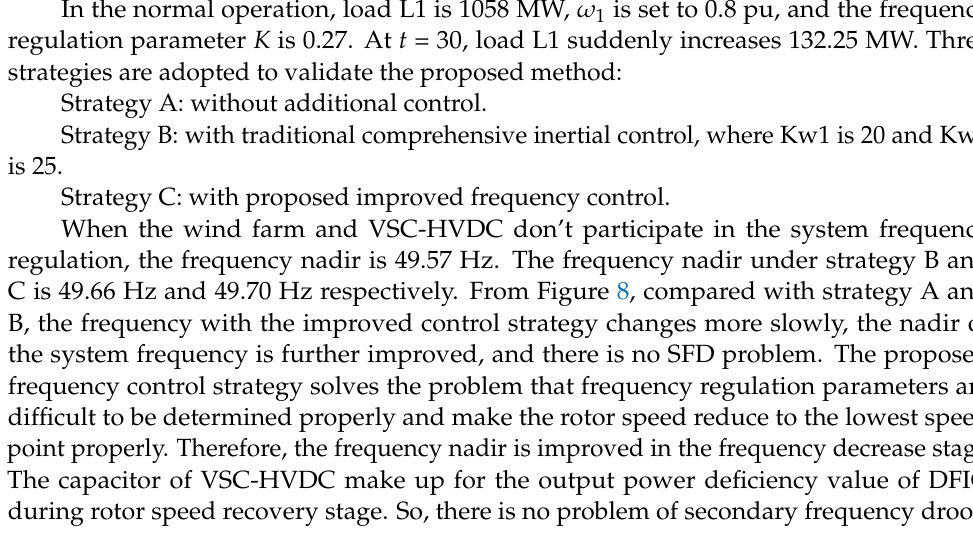
P Δ . Figure 7. Response of compensated power of VSC of different ∆ P e e